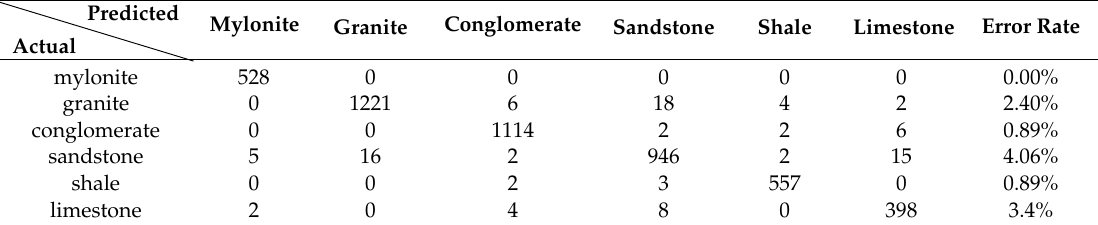
Table 5. Confusion matrix of the RTCNNs model based on the testing dataset.